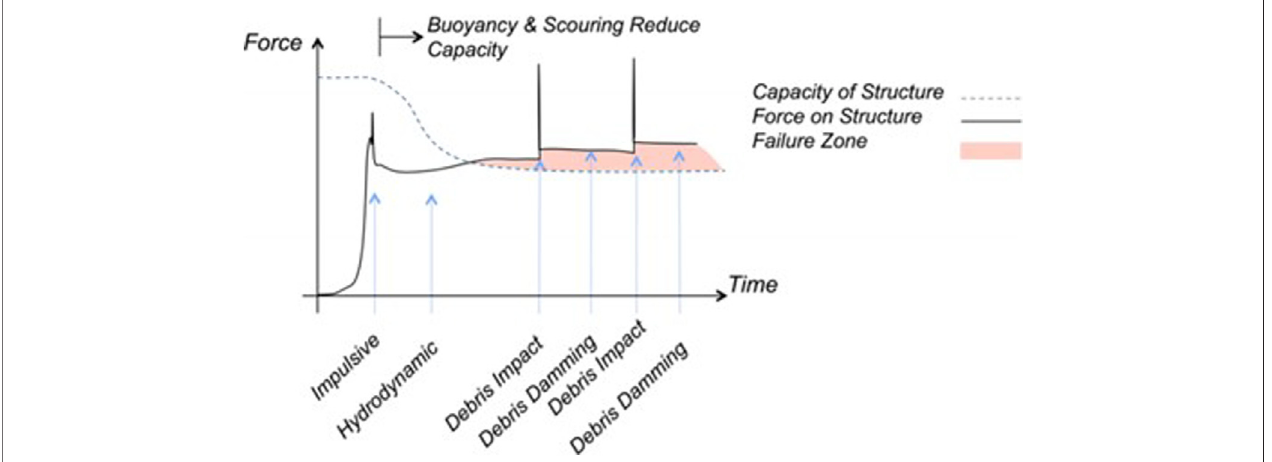
FIGURE 1 | Typical qualitative time series of loading on a building during tsunami inundation (Yeh et al., 2014).